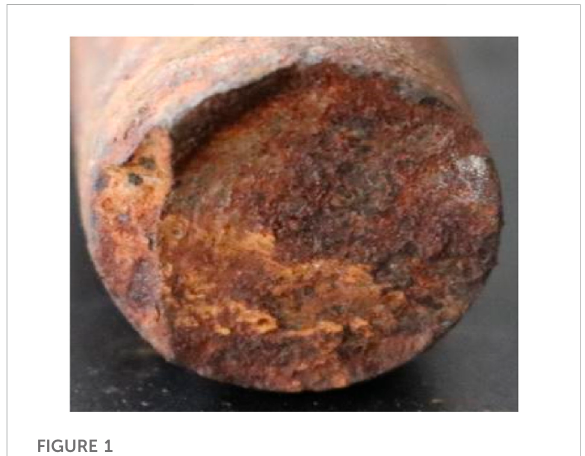
FIGURE 1 Fatigue cross-sectional shape of the pumping rod.